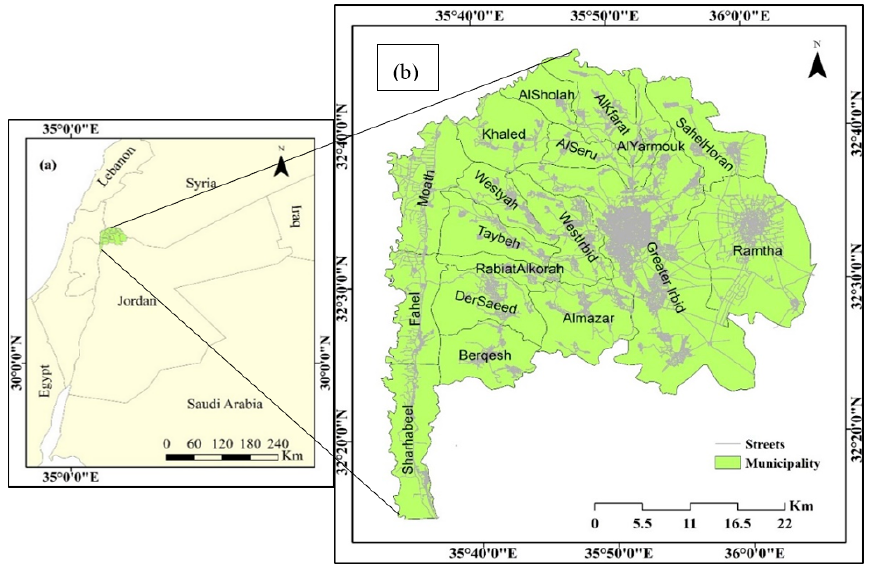
Figure 1. ( a ) location map of the Irbid Governorate in Jordan and ( b ) administrative boundaries of the 18 municipalities in the Governorate.